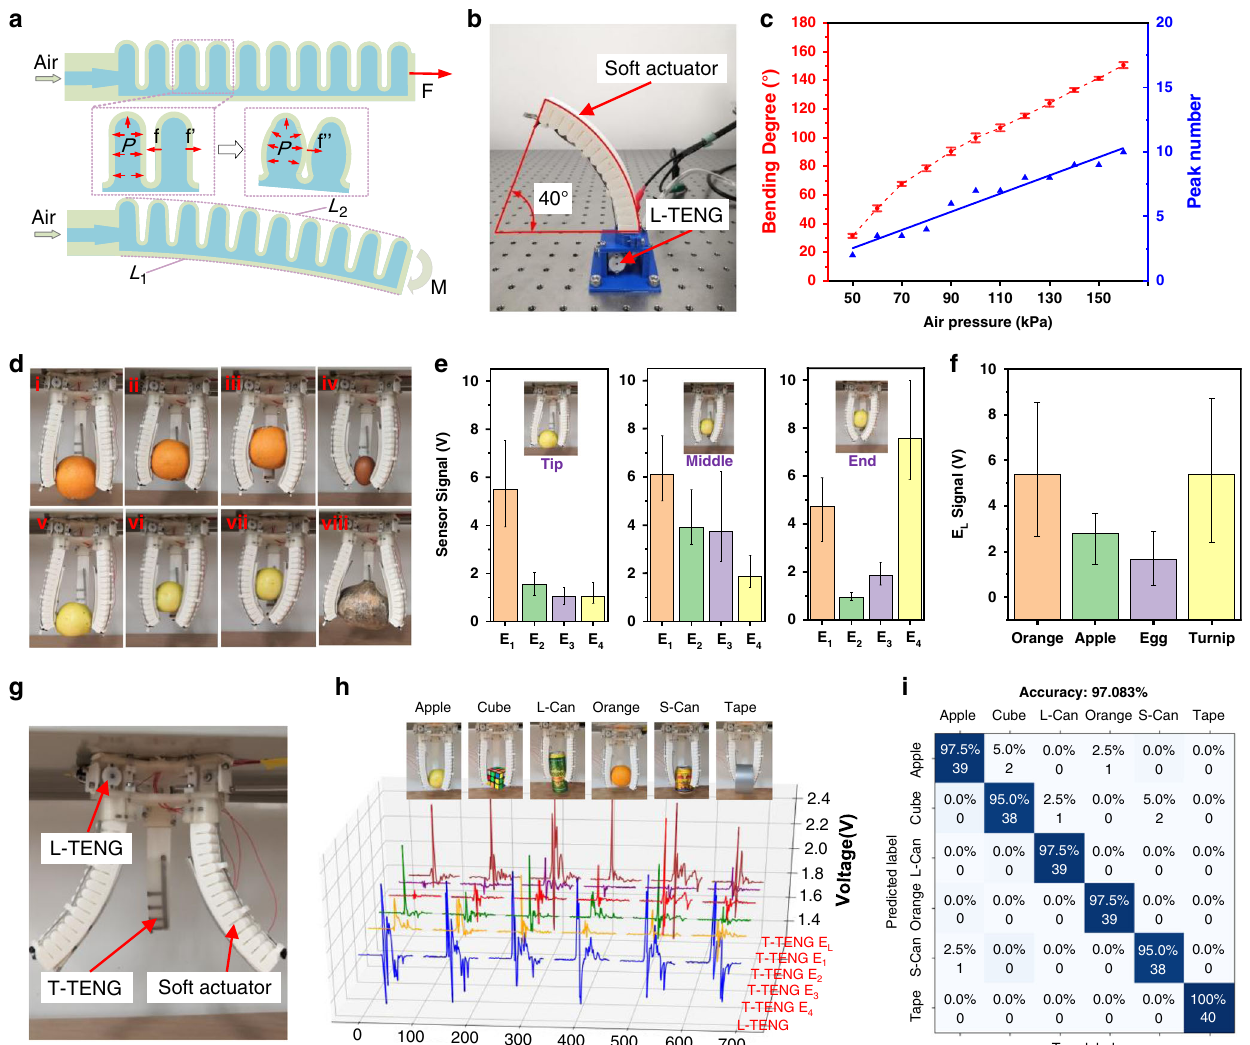
Fig. 4 Veri fi cation of the soft actuator integrated with TENG sensors and the results of machine learning training. a The operation mechanism of the soft actuator. b The con fi guration of the device during the characterization of length TENG (L-TENG) sensor. c The output peak numbers from L-TENG sensor versus the bending degrees of the soft actuator with increasing air pressure. d The diagrams of the gripper griping various objects with different contact positions to test T-TENG sensor. (i – iii) Gripping orange in different positions, (iv) gripping egg, (v – vii) gripping apple in different positions, and (viii) gripping turnip. e The output signals of tactile TENG (T-TENG) sensor for gripping an apple in various contact positions. f The output of long electrode (E L ) when gripping various objects with different curvatures. g The con fi guration of the gripper and sensors. h 3D plots of the robotic sensor outputs responding to different objects (apple, cube, long can (L-Can), orange, short can (S-Can), and tape). i The confusion map for machine learning